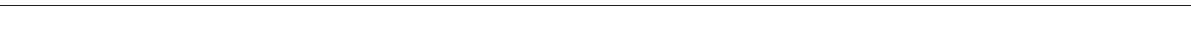
Fig. 4 Intracellular FAK-Rac1 signaling is activated upon IbeA – Caspr1 interaction. a HBMECs lysates were immunoprecipitated (IP) with Caspr1 and FAK antibody, respectively, and then the precipitated proteins were analyzed by western blot (WB) using antibodies against FAK and Caspr1. b HBMECs were infected with E44 or ZD1 (with MOI of 100) for the indicated times and the cell lysates were subjected to IP analysis as described in ( a ). c HBMECs were infected with E44 or ZD1 for the indicated times, and the cell lysates were examined by western blot with antibodies against FAK and phosphorylated FAK at Tyr397. d HBMECs were treated with GST-tagged IbeA protein or GST alone for the indicated times, and then the cells were lysed and subjected to IP analysis as described in ( a ). e HBMECs treated with GST-IbeA or GST were lysed and the samples were subjected to western blot to analyze FAK phosphorylation. f , g The Caspr1 in HBMECs was knocked out by CRISPR-Cas9 technique veri fi ed by western blot. The FAK phosphorylation in Caspr1- depleted HBMECs in response to E. coli infection ( f ) and GST-IbeA treatment ( g ) was examined by western blot. h HBMECs were stably transfected with Caspr1 mutant with deletion of cytoplasmic tail (Caspr1 Δ C), then the HBMECs were infected with wild-type E. coli (E44) for the indicated times. FAK phosphorylation was analyzed by western blot. HBMECs transfected with vector served as control. i HBMECs stably transfected with Caspr1 Δ C were subjected to bacterial invasion assay. Values are means ± SD from three independent experiments. *** P < 0.001, one-way ANOVA. j HBMECs stably transfected with Caspr1 Δ C were infected with E44 for the indicated times, and then the cells were lysed and the activation of Rac1 was measured. k HBMECs were transiently transfected with FAK siRNA, with non-silencing siRNA as a control. Then the cells were treated with E44 or GST-IbeA for 30 min and Rac1 activation was examined. FAK levels were analyzed by western blot with GAPDH as a loading control. All the images are representative of three independent experiments. The full blots are shown in Supplementary Fig. 8. The densities of the bands in western blots were quanti fi ed and analyzed for statistical signi fi cance. * P < 0.05; ** P < 0.01; *** P < 0.001, one-way